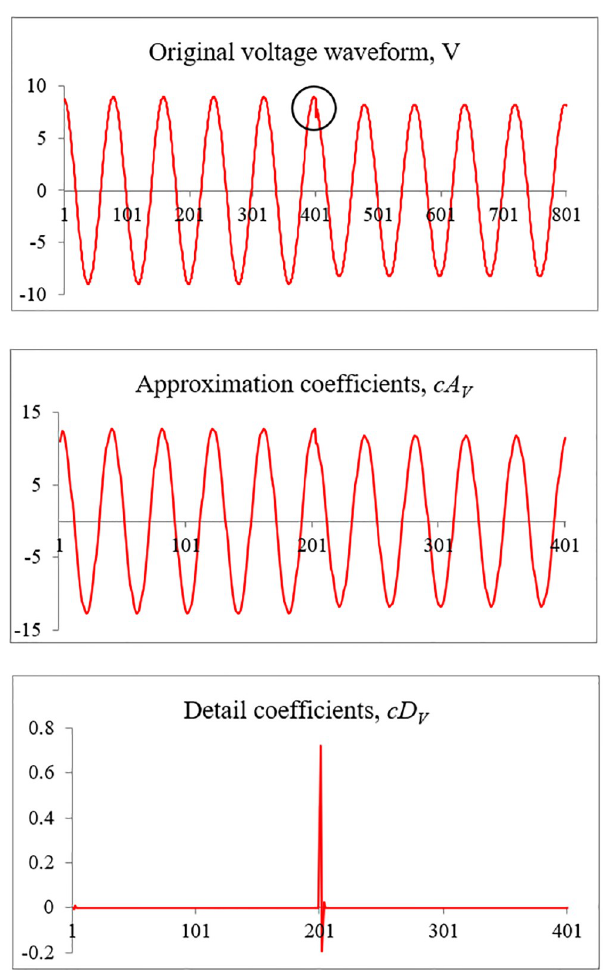
Fig 3. Extracted coefficients using Db4 mother wavelet. (A) Original voltage waveform. (B) Approximation coefficients. (C) Detail coefficients.